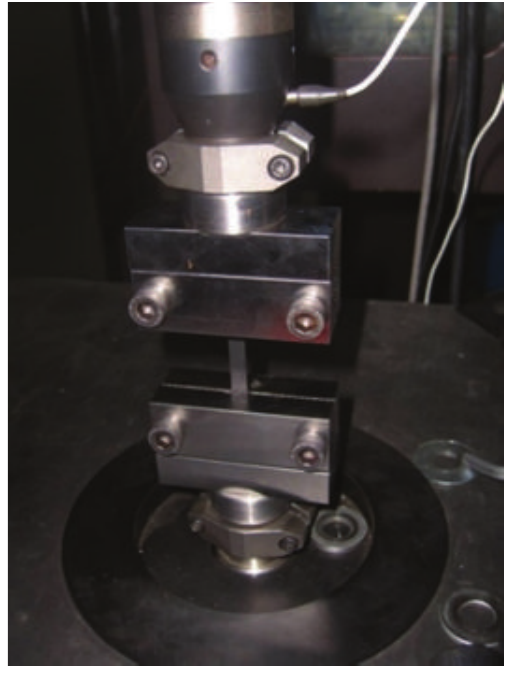
Figure 3: Uniaxial tension material test.